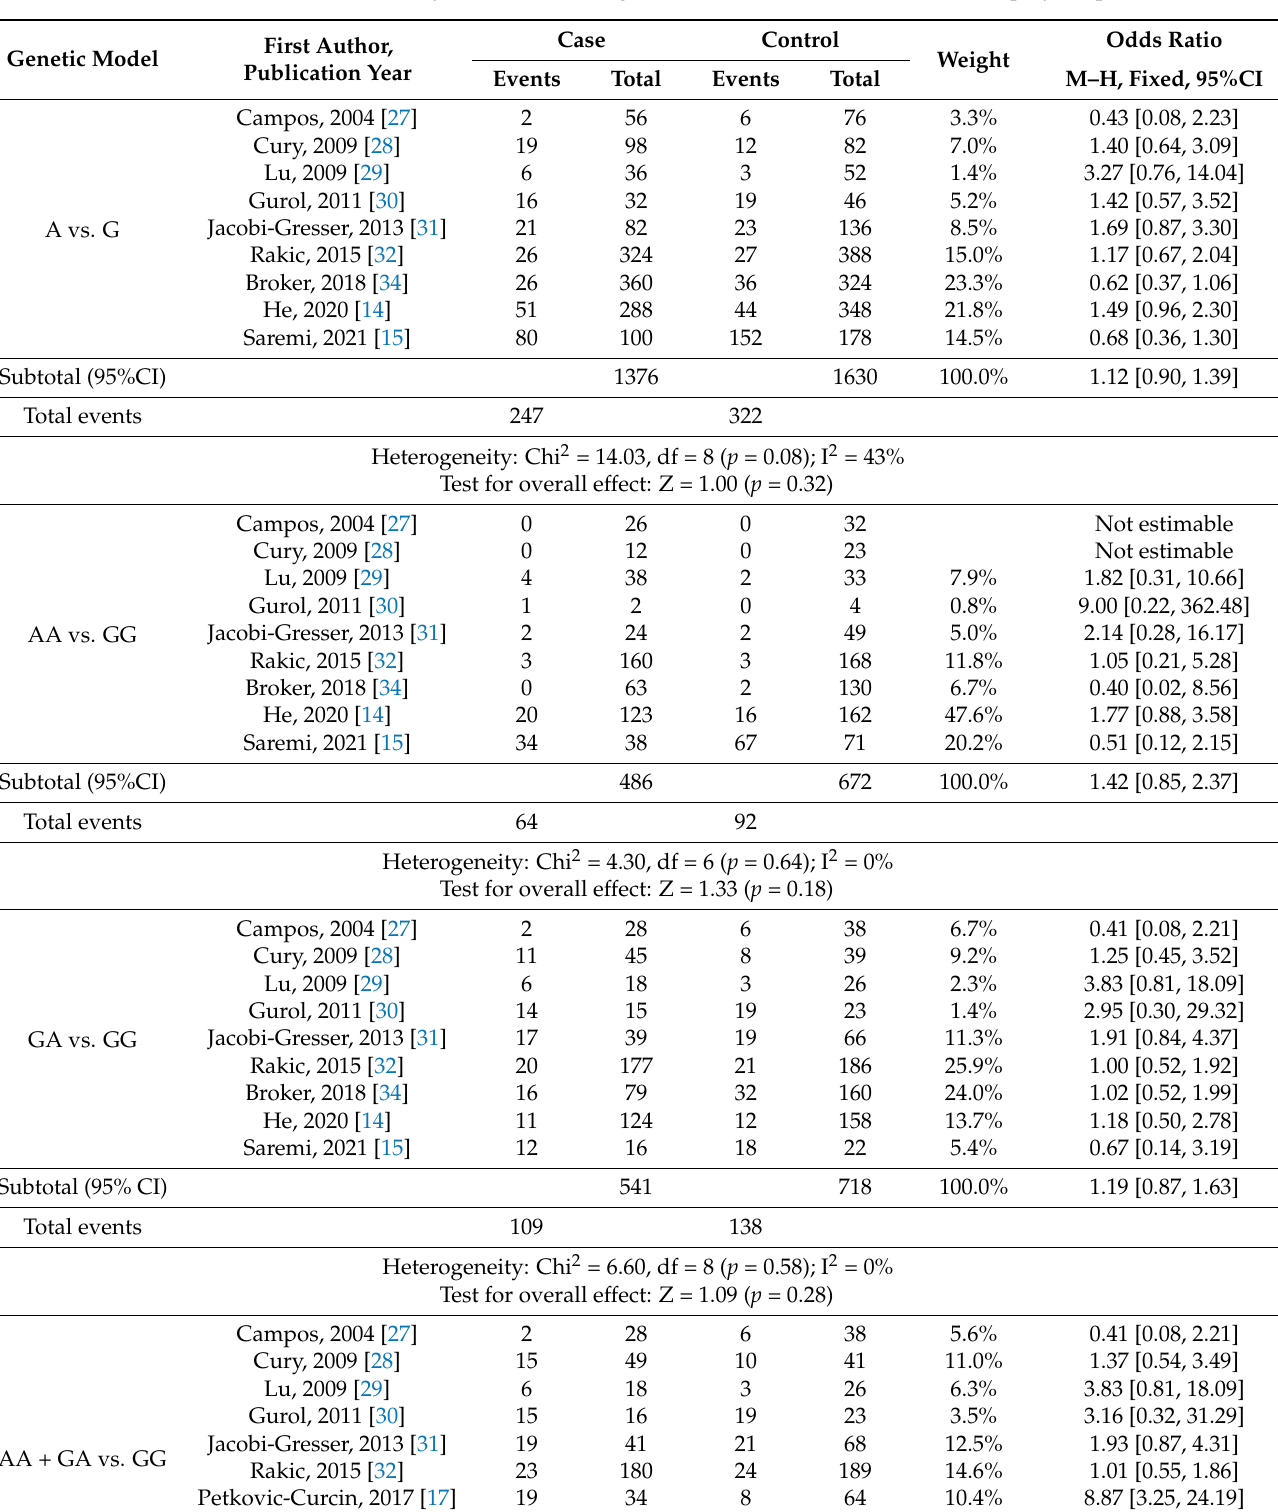
Test for overall effect: Z = 1.09 ( p =